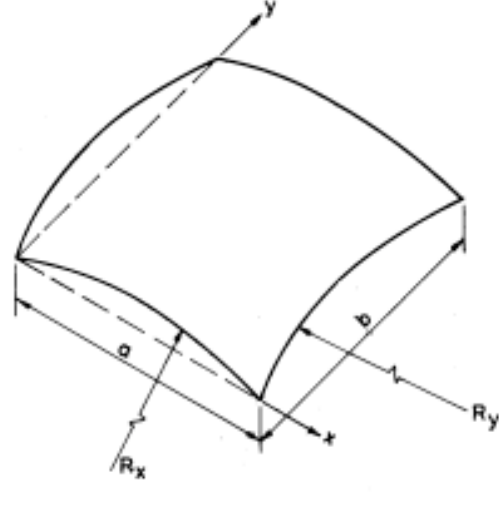
Fig. 2. Geometry and axis system of a doubly curved shell